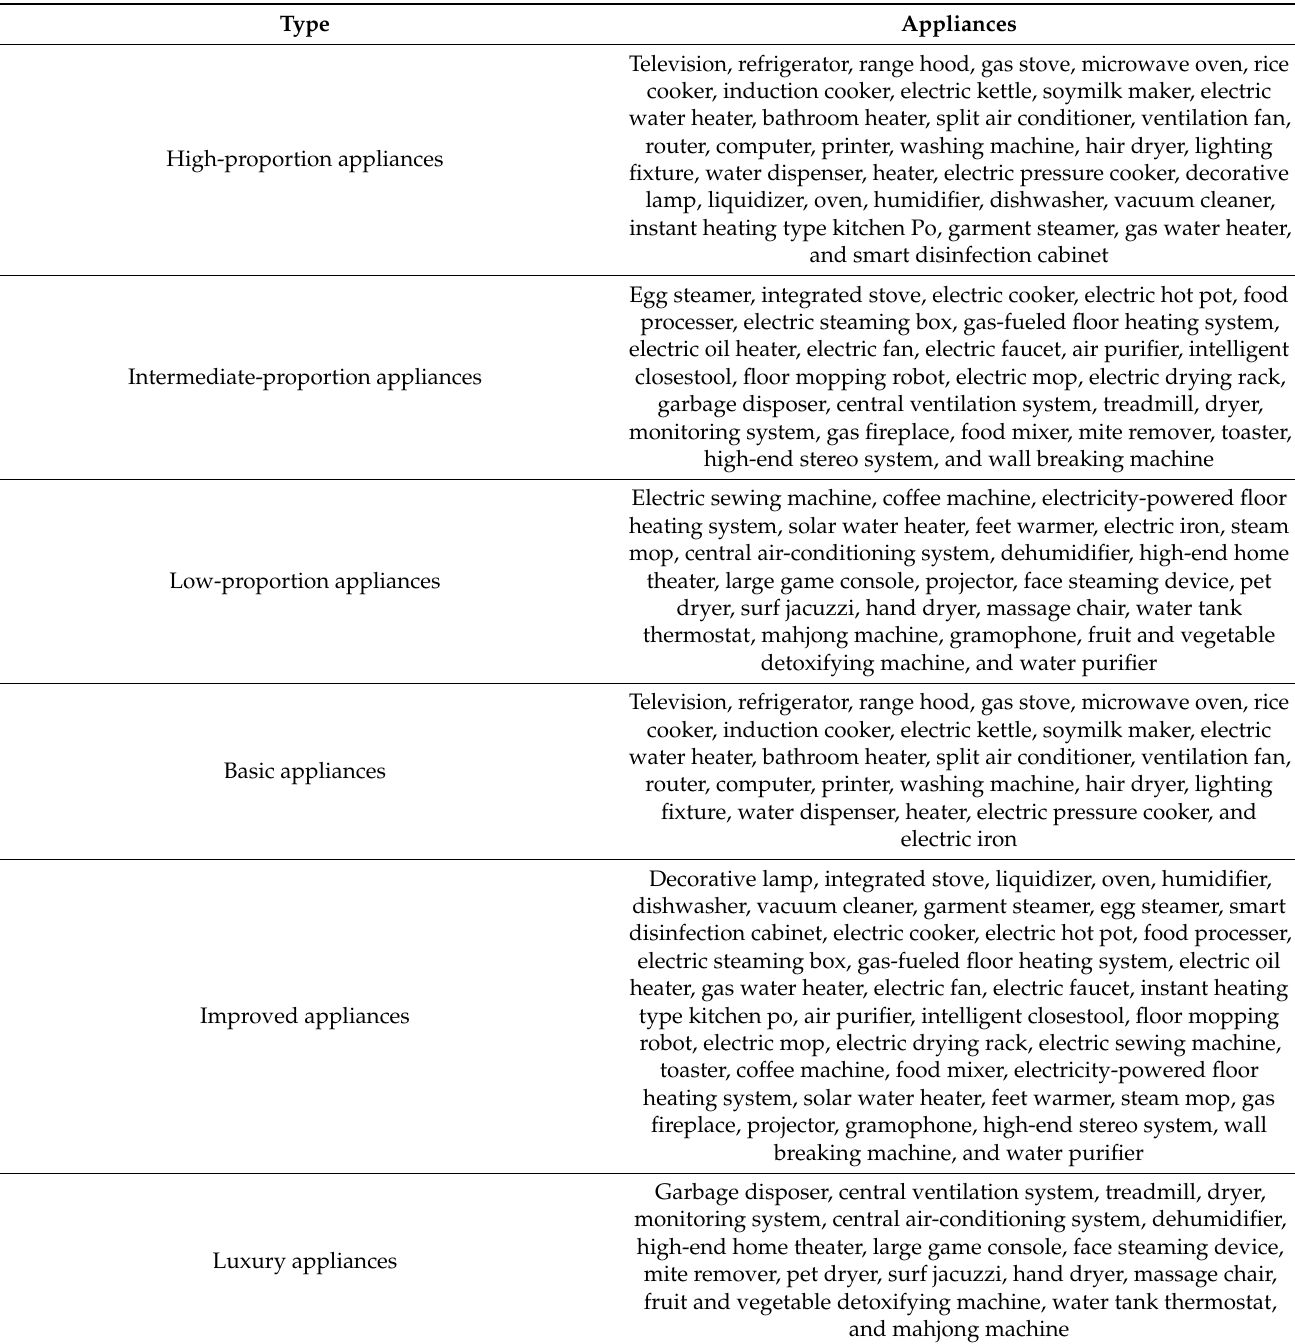
Table 2. Classification of household